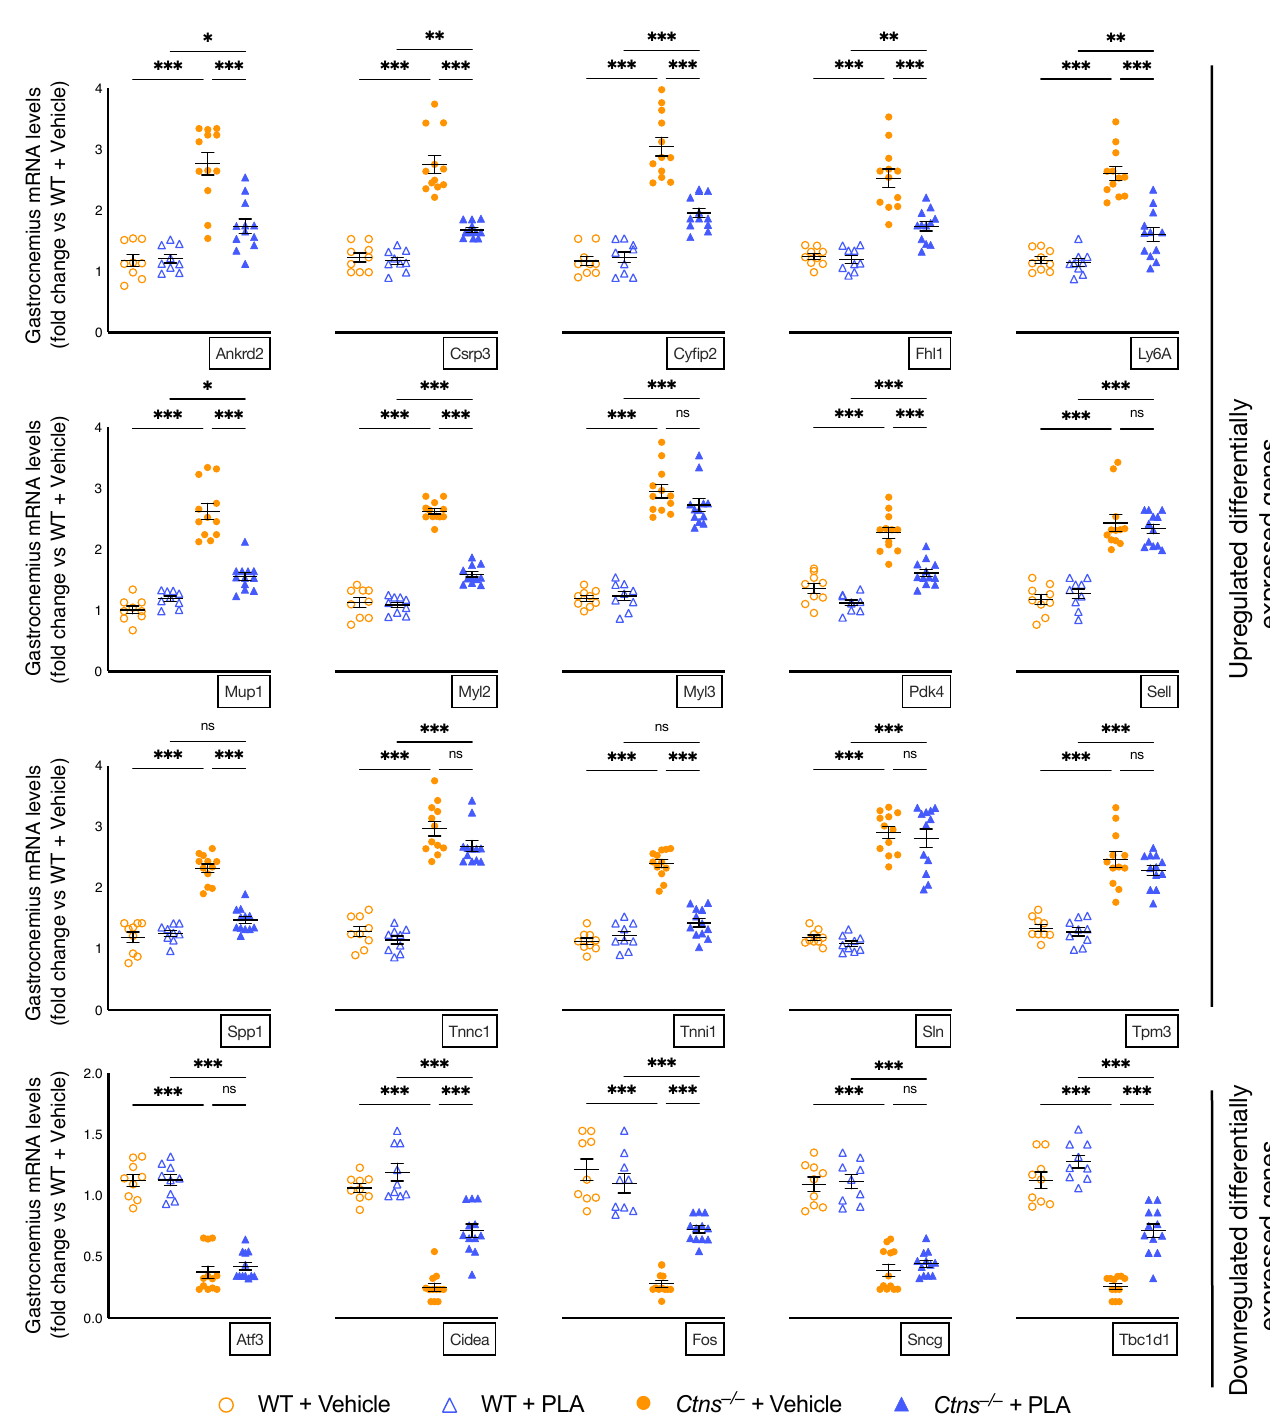
WT + Vehicle WT + PLA Ctns –/– + Vehicle Ctns –/– + PLA Figure 6. PLA attenuates expression of gastrocnemius muscle genes in Ctns − / − mice. PLA attenuated or normalized (Ankrd2, Csrp3, Cyfip2, Fhl1, Ly6A, Mup1, Myl1, Pdk4, Spp1 and Tnni1) as well as (Cidea, Fos and Tbc1d1) muscle gene expression in Ctns − / − mice relative to PLA-treated WT mice. Nonsignificant changes were observed in Myl3, Sell, Sln, Tnnc1 and Tpm3 as well as Atf3 and Sncg. Gastrocnemius muscle expression of targeted molecules was measured by qPCR. Final results were expressed in arbitrary units, with one unit being the mean level in vehicle-treated WT mice. In addition, results of PLA-treated Ctns − / − mice were compared to vehicle-treated Ctns − / − mice and specific p -values are shown above the bar. ns signifies not significant, * p < 0.05, ** p < 0.01, *** p < 0.001.